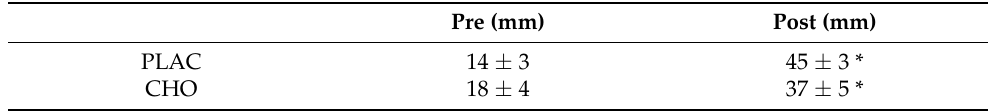
Table 2. Perceived mental fatigue before and after repeated SWCT when using (PLAC) or carbohy- drate (CHO) mouth rinse.